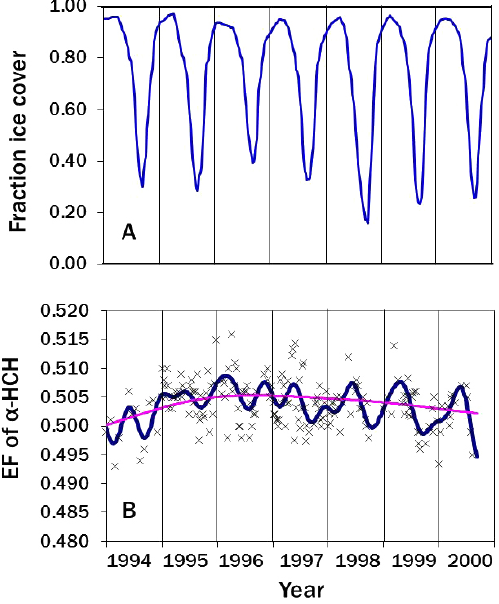
Figure 2. (a) Fractional ice cover in the Canadian Arc- tic (Canadian Archipelago–southern Beaufort Sea), from IceGraph 2.0 (http://www.ec.gc.ca/glaces-ice/?lang=En&n= A1A338F4-1&offset=5&toc=show) (accessed 6 July 2014). (b) Seasonal (blue) and long-term (pink) trends in the EFs of α -HCH in air at Alert, fitted by DF analysis (Hung et al., 2002). Experimental points are marked